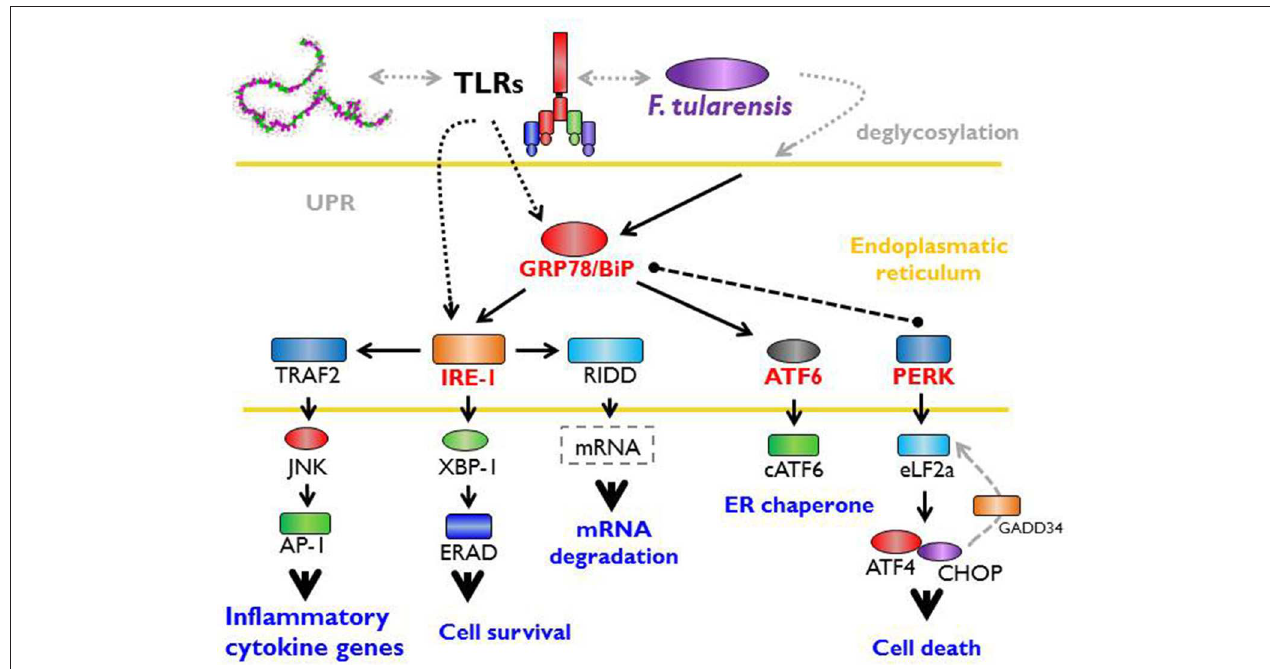
FIGURE 2 | Unfolded protein response, ER stress, and Francisella. The interaction between host and microbe damages cell integrity and activates the cell autonomous stress response. Signaling from PRRs (pattern recognition receptors) with parallel accumulation of misfolded or inappropriately post-translationally modified proteins in the endoplasmic reticulum (ER) triggers so called unfolded protein response (UPR). This important effect related to the intracellular existence of Francisella increases the expression of GRP78/BiP chaperone (binding immunoglobulin protein) required for proper folding of newly synthetized proteins and lead to the activation of IRE-1 (inositol-requiring enzyme 1). Moreover, Francisella modulates the activation of other two arms of UPR via activating transcription factor six and inhibition of protein kinase RNA-like endoplasmic reticulum kinase). Signaling events induce by Francisella associated with ER stress may be considered as a cell-autonomous defense mechanisms designated to the elimination of cell damage rather that to eliminate